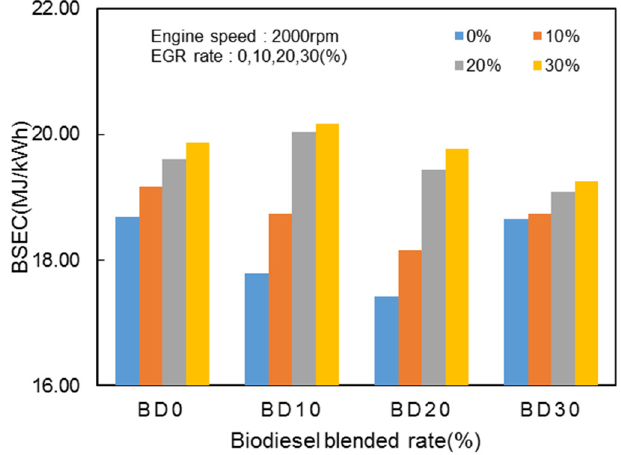
Figure 10. Effects of EGR and the biodiesel blend ratio on the